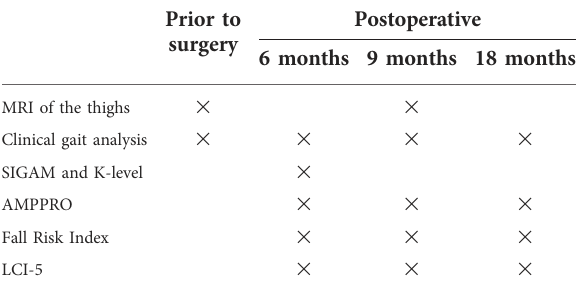
TABLE 1 Time schedule of the